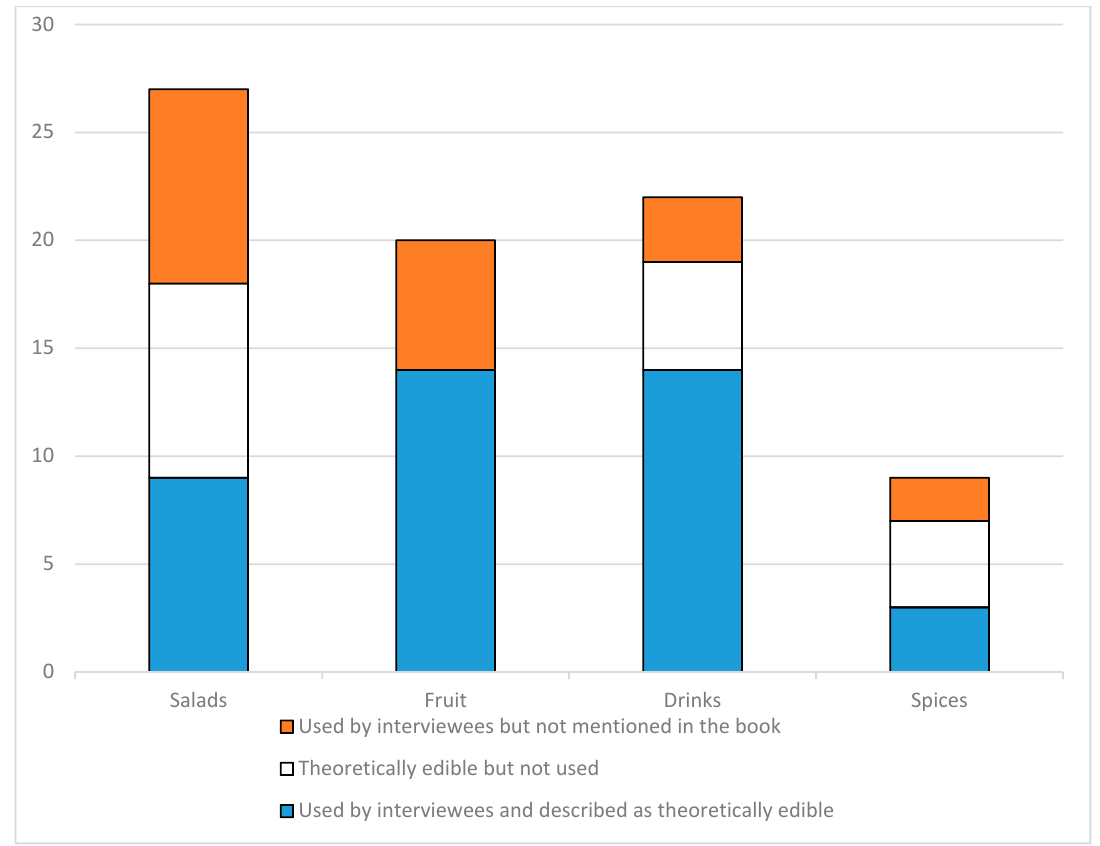
Figure 7. Categories in which theoretically edible wild plants can be used according to [81] and the proportion of the plants recommended in his study against the ones used by our interviewees.